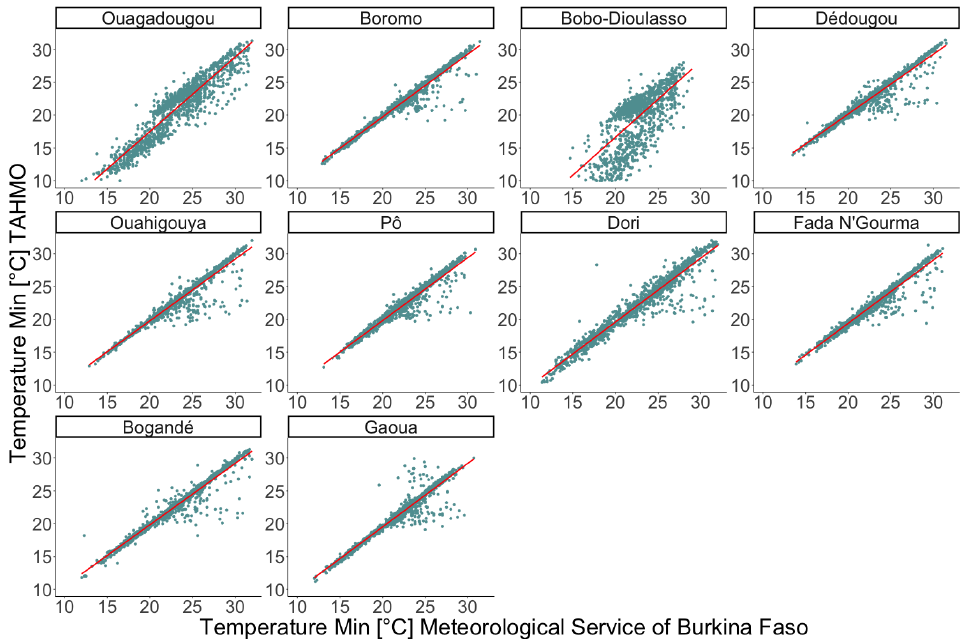
Figure 8. Scatterplot between minimum temperature time series of TAHMO stations ( y -axis) and the corresponding stations from meteorological service of Burkina Faso ( x